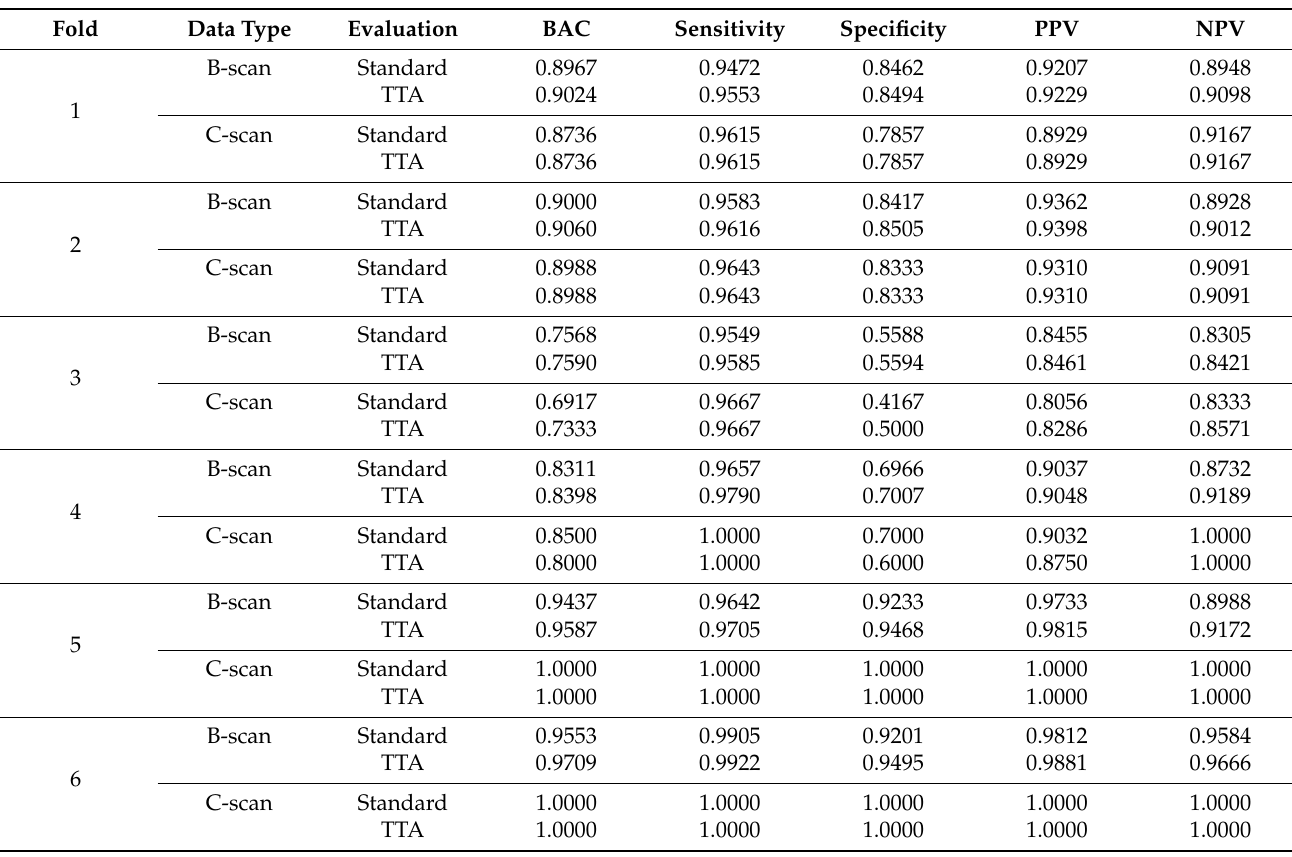
Table A2. Detail of the results of each fold for the different imaging modalities (B-scan vs. C-scans).